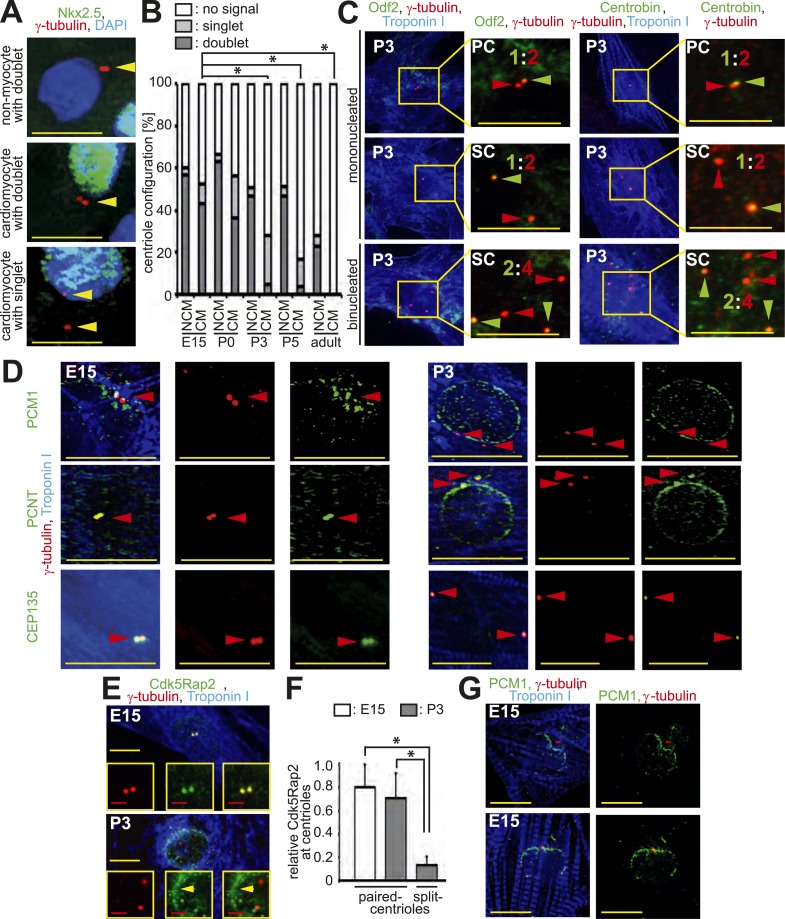
Loss of centrosome integrity during heart development.(A) Representative images of centrosomes (γ-tubulin) in heart cryosections of P0 rat heart ventricles. Nuclei: DAPI. Cardiac nuclei: Nkx2.5. Arrowheads indicate centrioles. γ-tubulin signals separated by a distance greater than 2 µm were considered as singlets. Scale bars: 10 µm. (B) Quantitative analysis of centriole signals and configurations in cardiomyocytes and non-myocytes from cyrosections of E15-, P0-, P3-, P5, or adult (2 months) rat heart ventricles. CM: cardiomyocyte. NCM: non-myocyte. Results are from three independent animals, data are mean ± SD, ≥ 100 cells were analyzed per experimental condition, *: p < 0.05 (refers to doublets). (C) Representative images of P3-isolated cardiomyocytes immunostained for mother centriole (Odf2) and daughter centrioles (Centrobin) (green arrowheads). SC: split-centrioles. Colored ratios equal daughter or mother centriole: all centrioles. (D) Analysis of the localization of the centrosome proteins PCM1, PCNT (Pericentrin), and CEP135 in isolated cardiomyocytes. Red arrowheads indicate centrioles. (E) Representative images of Cdk5Rap2 localization in E15- and P3-isolated rat cardiomyocytes. Yellow arrowhead: Cdk5Rap2 at the nuclear envelope. (F) Quantitative analysis of centriolar Cdk5Rap2 signal intensity in E15- and P3-isolated cardiomyocytes. Data are mean ± SD, n = 3, ≥ 10 cells were analyzed per experimental condition, *: p < 0.05. (G) Representative images of PCM1 localization in E15-isolated cardiomyocytes (Troponin I). Centrioles: γ-tubulin.